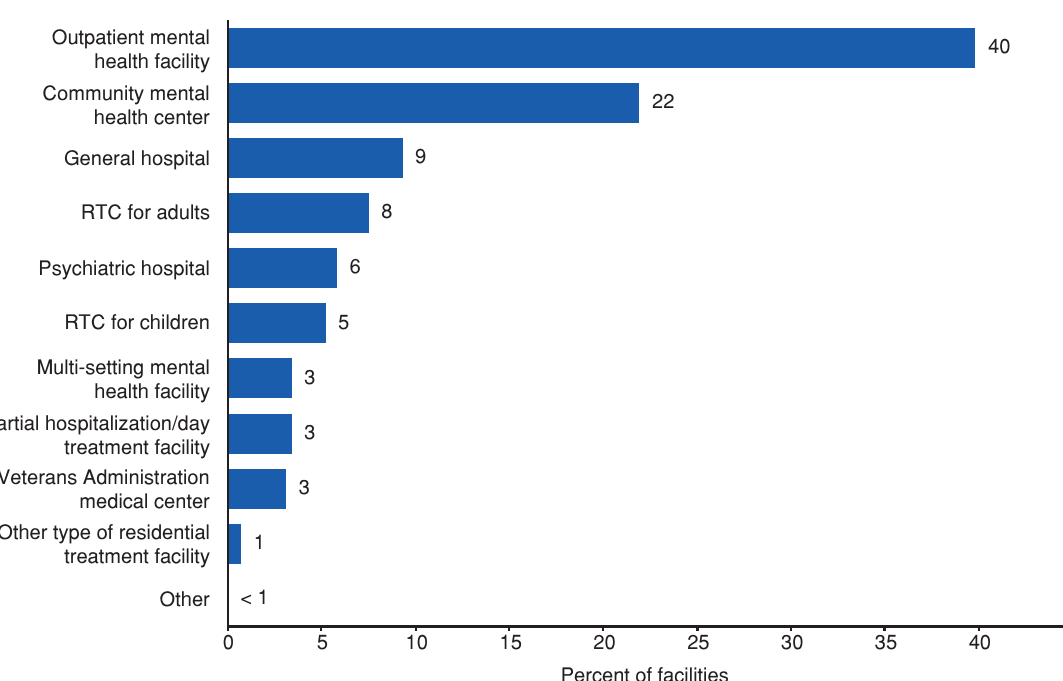
Figure 1. Facility type: